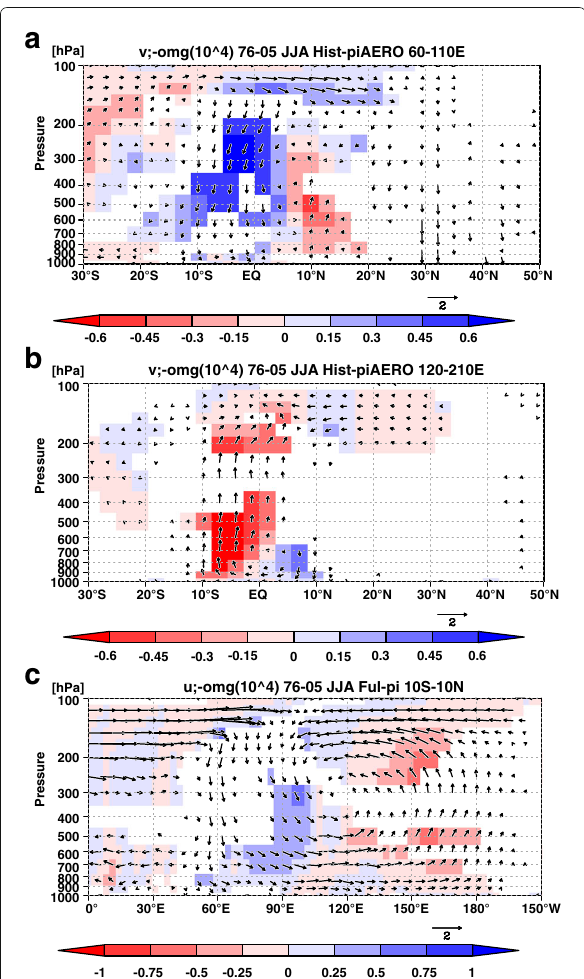
Fig. 4 a Latitude-vertical (in pressure) cross-section in meridional and vertical winds over the Asian monsoon region (60° E–110° E) during JJA. b Same as Fig. 5a, but over the Pacific Ocean (120° E–150° W) during JJA. c Longitude-vertical (in pressure) cross-section in zonal and vertical winds along the equator (10° S–10° N) during JJA. As we used ω , we multiplied ω by − 1 for vectors to understand vertical motions. The plotted vectors are statistically significant for horizontal or vertical components, or both. The red (blue) color indicates ascending (descending) motion. The unit of zonal and meridional winds is m s − 1 . The unit of ω is 10 − 4 Pa s − 1 . The plotted colors are statistically significant for the vertical component